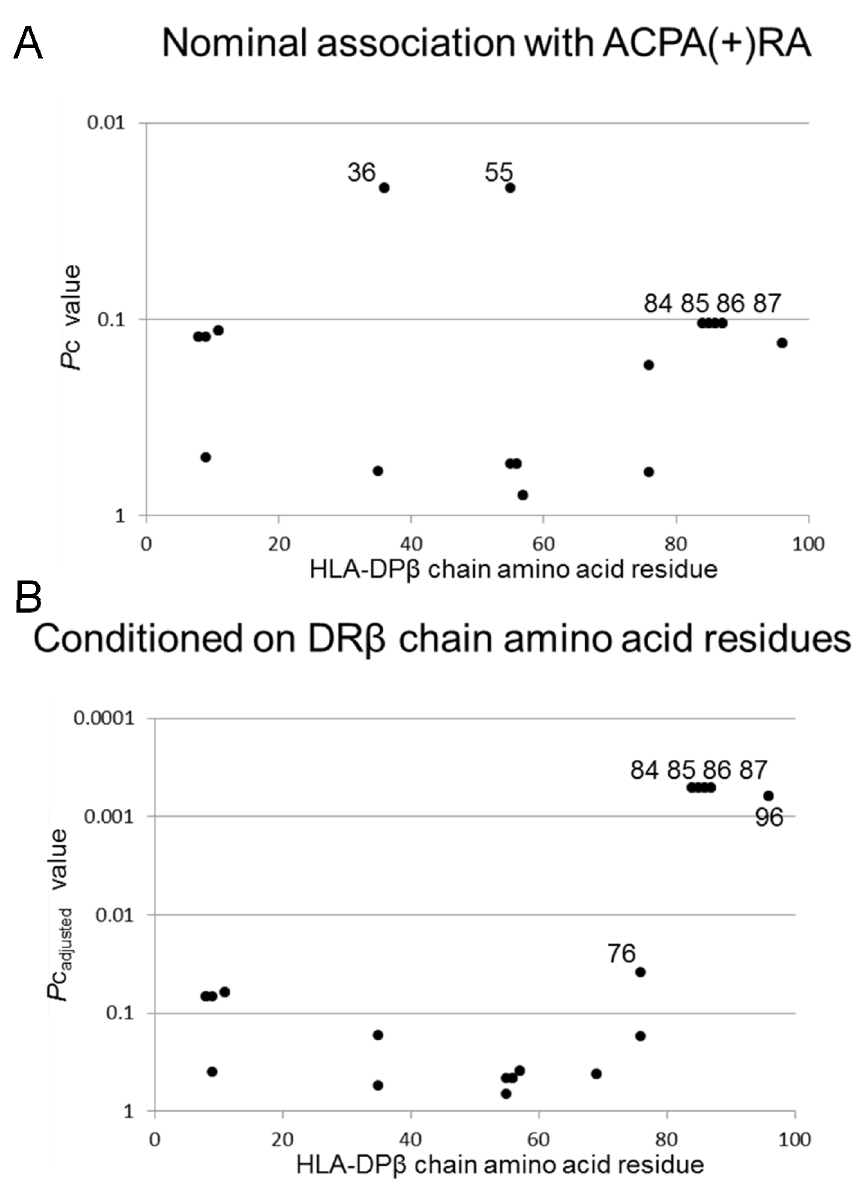
Fig 1. Associations of amino acid residues in the DP β chains with ACPA(+)RA. (A) Association was established between ACPA(+)RA and controls by logistic regression analysis. (B) Conditional logistic regression analysis was performed to clarify whether each DP β chain amino acid residue was independently associated with ACPA(+)RA. P adjusted values were calculated for amino acid residues in the DP β chains, when conditioned on DR β chain amino acid residues. Corrected P ( P c) values were obtained by multiplying the P value by the number of amino acid residues tested. RA: rheumatoid arthritis, ACPA: anti-citrullinated peptide antibody, ACPA(+)RA: ACPA positive